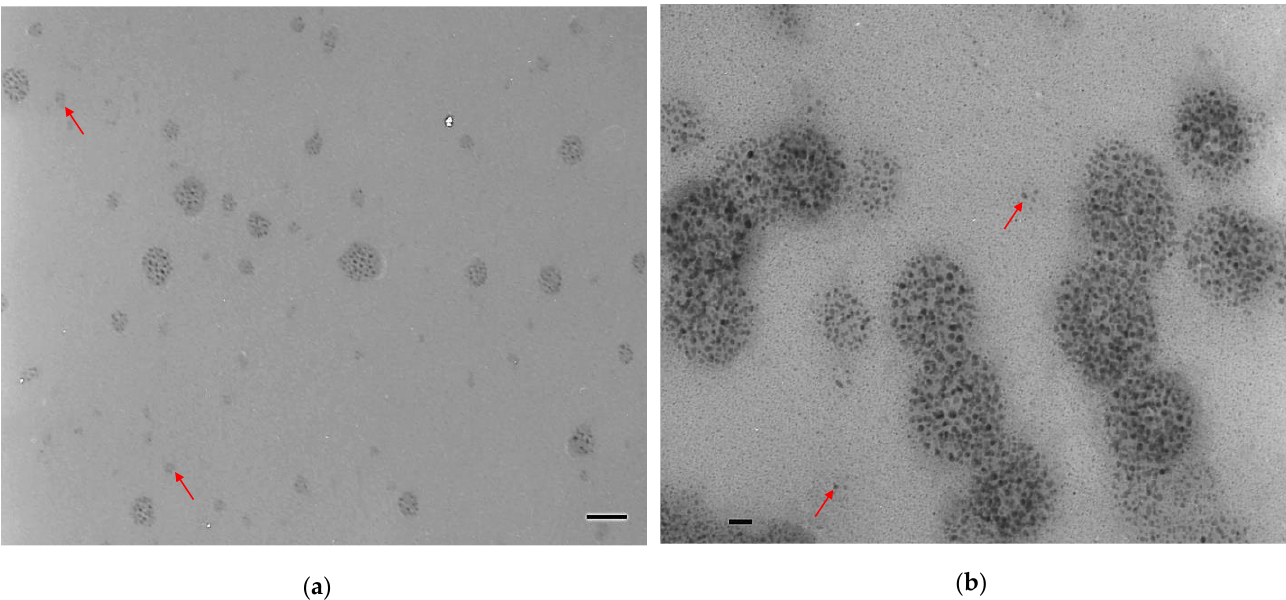
Figure 8. TEM micrographs of Pd-loaded linear dendritic block copolymers.: ( a ) (G1) 2 −PEG5k−(G1) 2 micellar Pd complex; ( b ) (G2) 2 −PEG11k−(G2) 2 micellar Pd complex. Scale bar: 50 nm. Red arrows mark possible Pd monomolecular micelle complexes. See Sections 2.2.6 and 2.3.8. in ‘Materials and